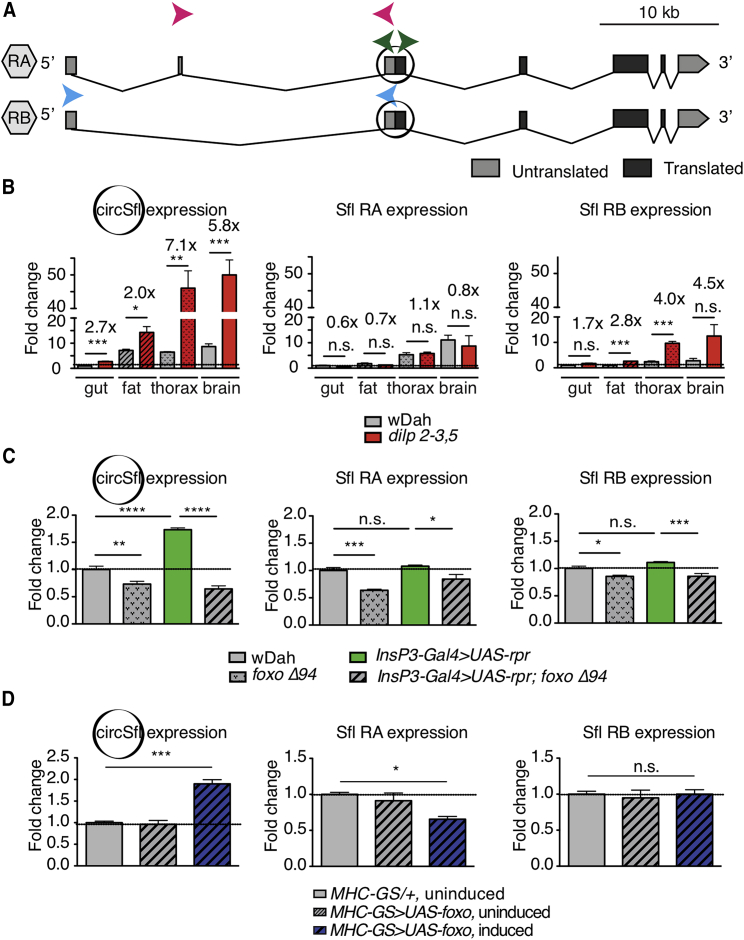
CircSfl Is Upregulated in Long-Lived Insulin Mutant Flies in a dFoxo-Dependent Manner(A) Scheme of the sulfateless gene locus, including primers used to differentiate between circSfl (green arrows), Sfl RA (pink arrows), and Sfl RB (blue arrows).(B) circSfl and Sfl RB, but not Sfl RA, were upregulated in all tissues of dilp 2-3,5 mutants (∗p < 0.05, ∗∗p < 0.01, ∗∗∗p < 0.001, Student’s t test, mean ± SEM).(C) circSfl, but not Sfl RA and RB, was upregulated in flies lacking insulin-producing cells (InsP3>UAS-rpr, whole female flies). Upregulation of circSfl was dependent on the dFoxo transcription factor (∗∗p < 0.01, ∗∗∗∗p < 0.0001; interaction MNC ablation and dFoxo, p < 0.0001; 2-way ANOVA with Bonferroni post hoc test, n = 3, mean ± SEM).(D) circSfl was upregulated in thoraces of flies overexpressing dFoxo in muscle (∗∗∗p < 0.001, 1-way ANOVA, n = 3, mean ± SEM), Sfl RA was downregulated, and expression of Sfl RB was unchanged. All flies were 10 days old.See also Figure S2.